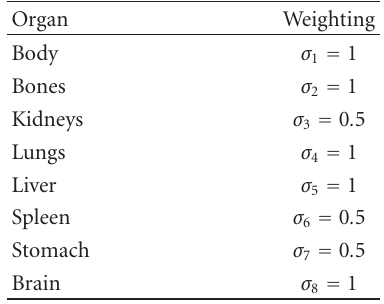
Table 1: Segmented organs used for full body